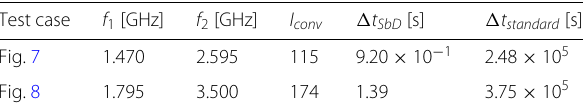
Table 3 SbD validation. Figures of merit and computational time of the optimized antennas